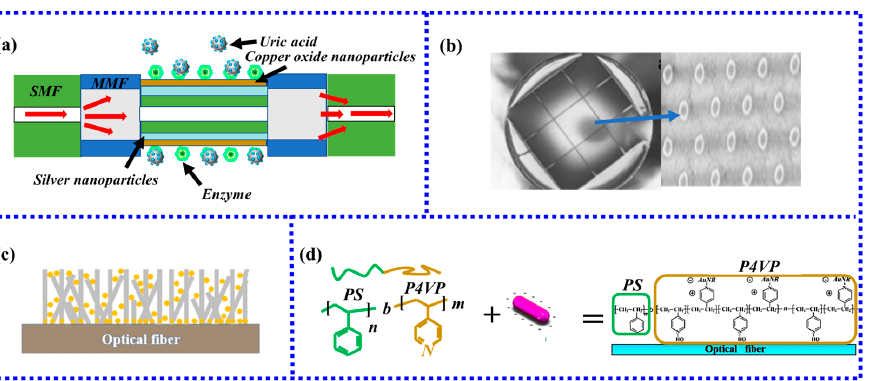
Figure 6. ( a ) Fiber-optic sensing probe for uric acid detection. ( b ) Gold nanodisk array sensing probe [64]. ( c ) Schematic diagram of ZnO nanowires and AuNPs composite structure [66]. Copyright 2023, Elsevier; ( d ) Schematic diagram of the PS-b-P4VP-templated citrate-AuNR monolayer [48]. Copyright 2023, Elsevier.